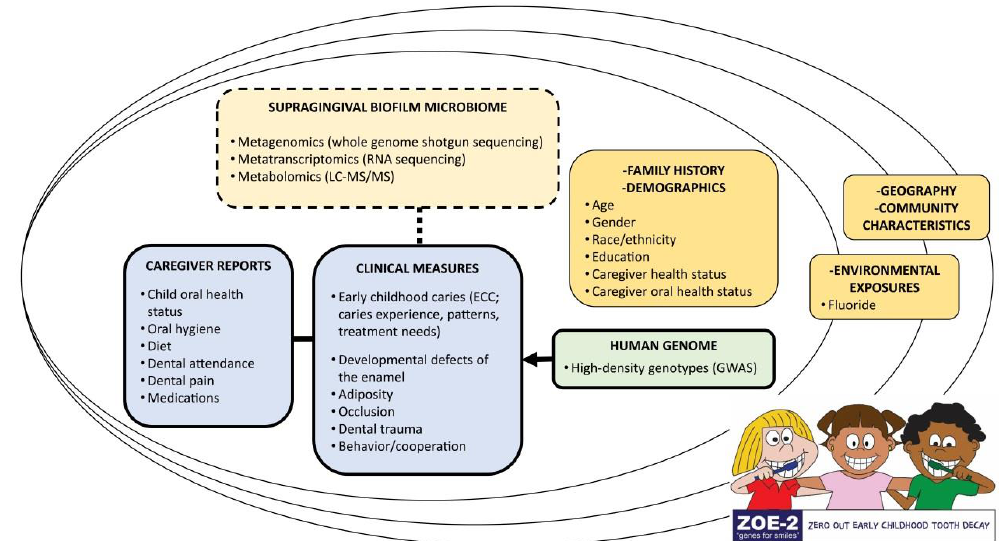
Figure 1. Overview of data domains and measures collected in the ZOE 2.0 study, North Carolina, United States. Adapted with permission from Divaris and Joshi 2020 [20]. To date, supragingival biofilm microbiome analyses have been carried out in a pilot subset of 300 ZOE 2.0 participants (~5% of those with clinical